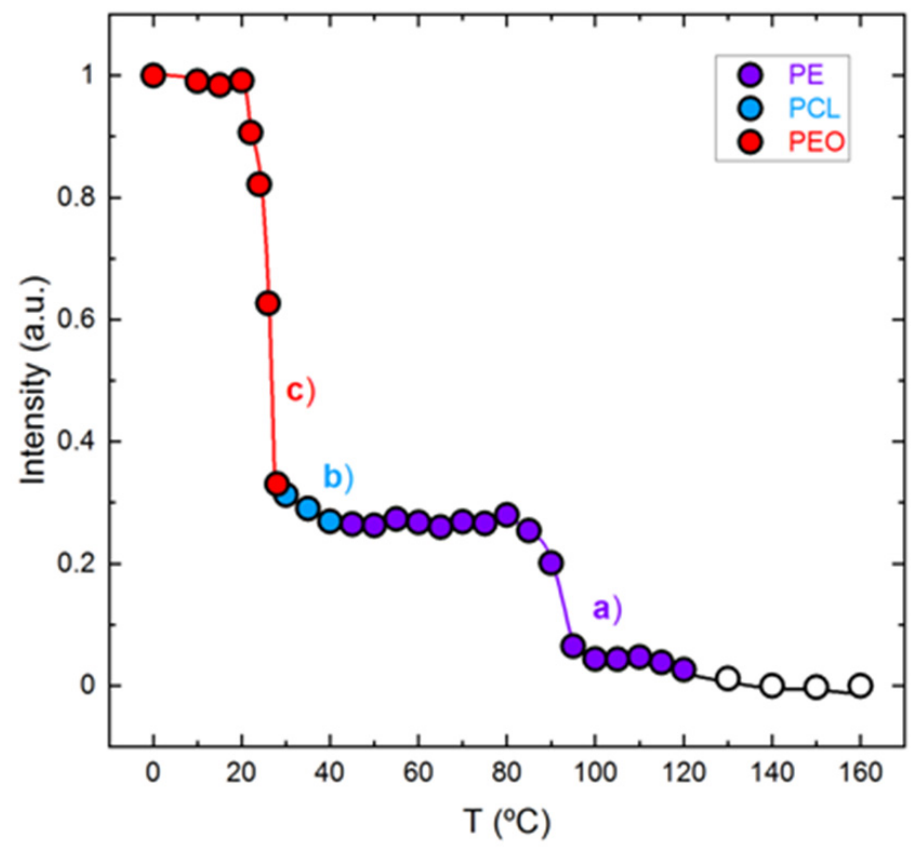
Figure 10. PLOM micrographs of the triblock terpolymer PE 22 7.1 -b- PEO 4615.1 -b- PCL 3210.4 (T1) cooling the sample from the melt at 20 °C/min. Colored squares (violet for PE, blue for PCL, and red for PEO) refer to the crystallized block at their corresponding temperature, indicated at the top of the micrographs for ( a ) molten state at 120 °C, ( b ) PE at 80 °C, ( c ) PE and PCL at 40 °C, ( d ) PE, PCL and PEO at 30 °C, and ( e ) PE, PCL, and PEO at 0 °C .